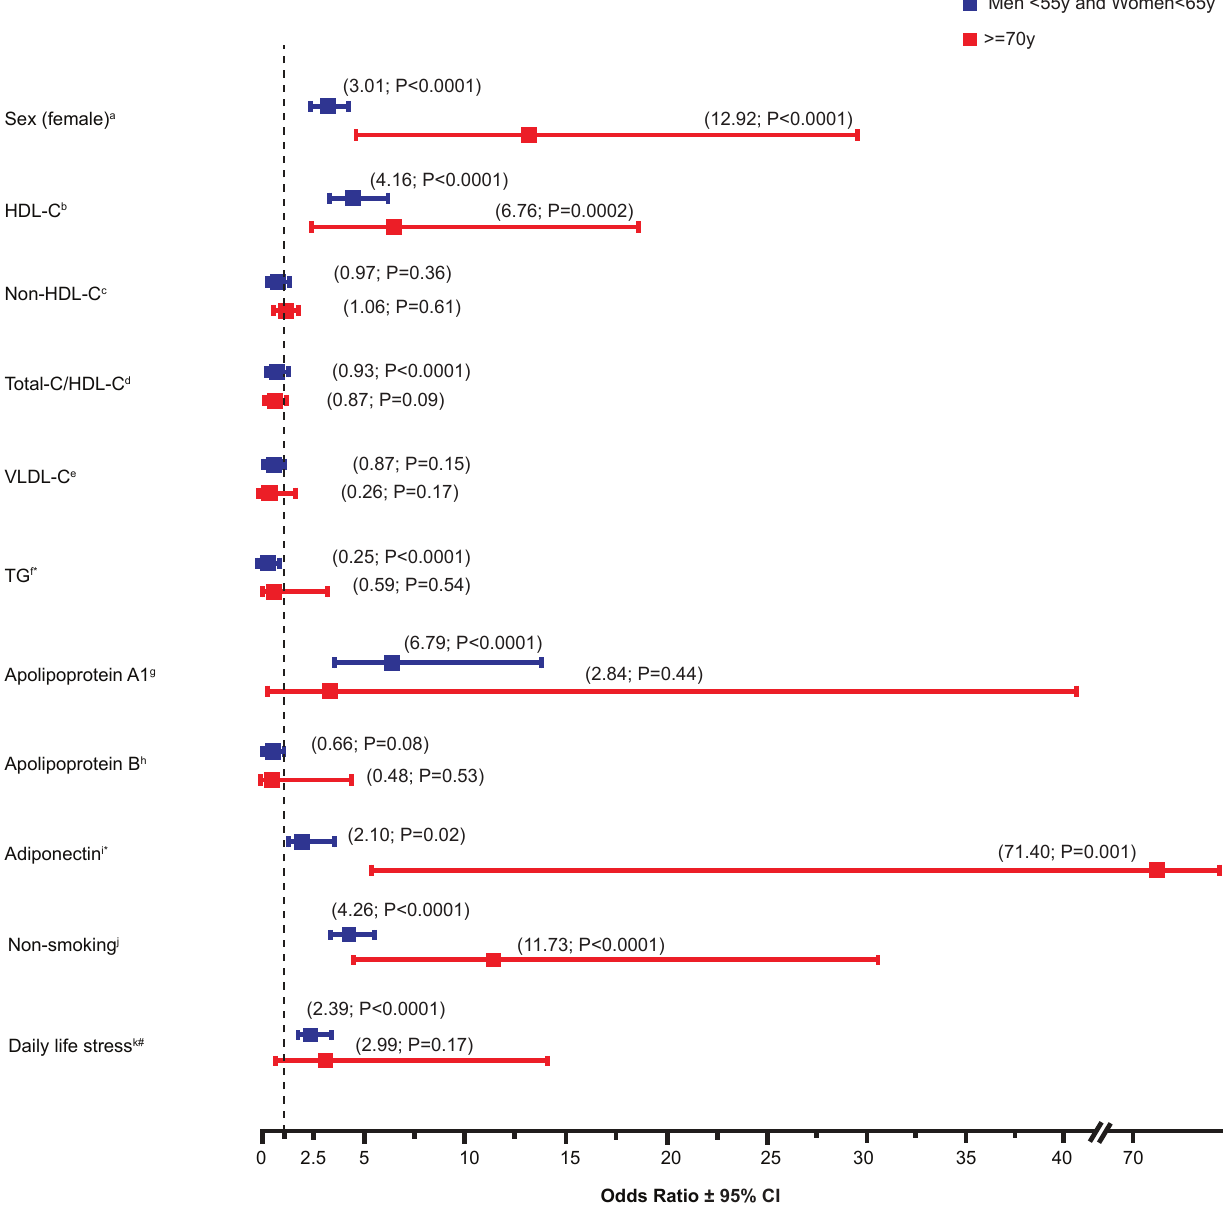
Figure 2. Univariate analysis of the contribution of biological and environmental variables to the relative odds of CVE-free survival in FH patients. Data represent the odds ratio of sex (female), various lipid parameters as well as non-smoking and daily life stress (low-to-moderate) on cardiovascular events (CVE)-free survival. Lipid-lowering drug treatment was included in all models. Statistical significance is defined with a p -value < 0.05. * Plasma adiponectin and triglycerides values were log 10 -transformed. # As compared to high-to-extreme stress. a ( n = 458 (group 1), n = 1297 (group 2); n = 24 (group 3)); b ( n = 457 (group 1), n = 1292 (group 2); n = 24 (group 3)); c ( n = 457 (group 1), n = 1289 (group 2); n = 24 (group 3)); d ( n = 457 (group 1), n = 1289 (group 2); n = 24 (group 3)); e ( n = 116 (group 1), n = 362 (group 2); n = 17 (group 3)); f ( n = 457 (group 1), n = 1294 (group 2); n = 24 (group 3)); g ( n = 223 (group 1), n = 472 (group 2); n = 8 (group 3)); h ( n = 219 (group 1), n = 628 (group 2); n = 9 (group 3)); i ( n = 268 (group 1), n = 695 (group 2); n = 12 (group 3)); j ( n = 453 (group 1), n = 1172 (group 2); n = 22 (group 3)); k ( n = 289 (group 1), n = 1009 (group 2); n = 15 (group